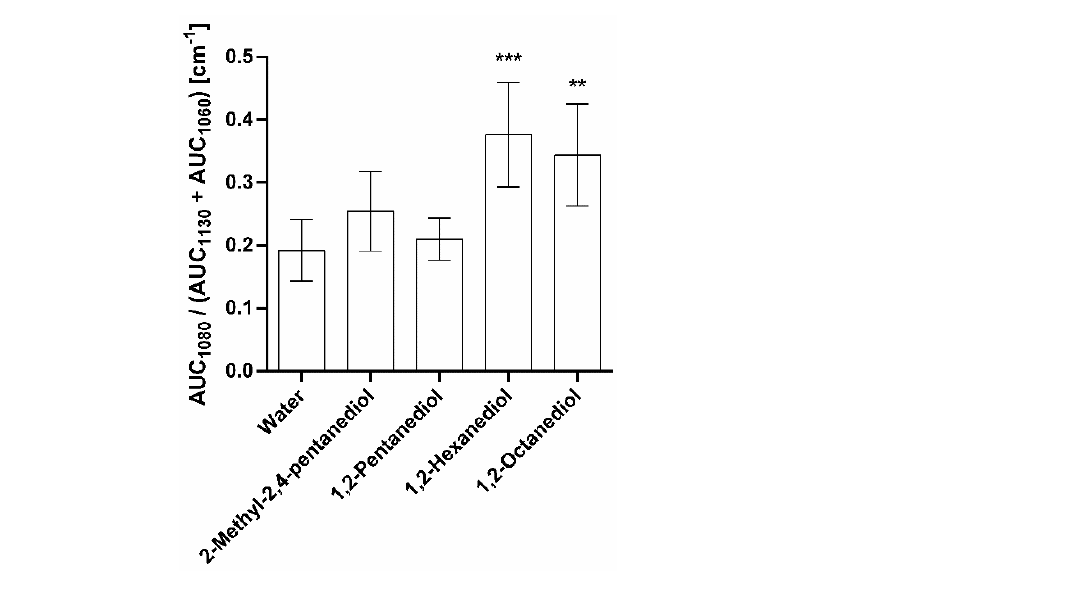
Figure 8. C-C skeleton vibration mode: calculation of ratio for lipid order analysis, after treatment with water and 5% solutions of 2-methyl-2,4-pentanediol, 1,2-pentanediol and 1,2-hexanediol, and saturated 1,2-octanediol solution, n = 9, mean ± SD, ** p ≤ 0.01; **** p ≤ 0.0001. 1,2-Pentanediol and 2-methyl-2,4-pentanediol do not show a significant effect on the lipid order compared to the water reference. In contrast, the longer-chained alkanediols,